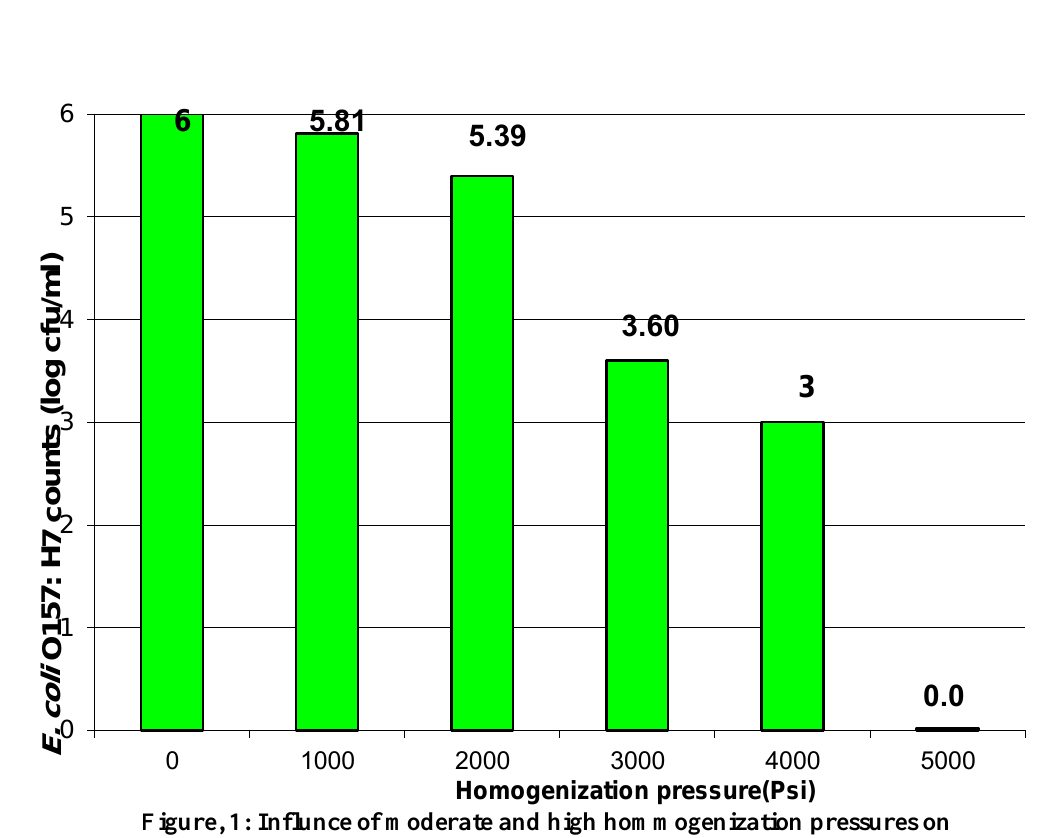
Figure, 1: Influnce of moderate and high hommogenization pressures on the viability loss of E. coli O157: H7 in